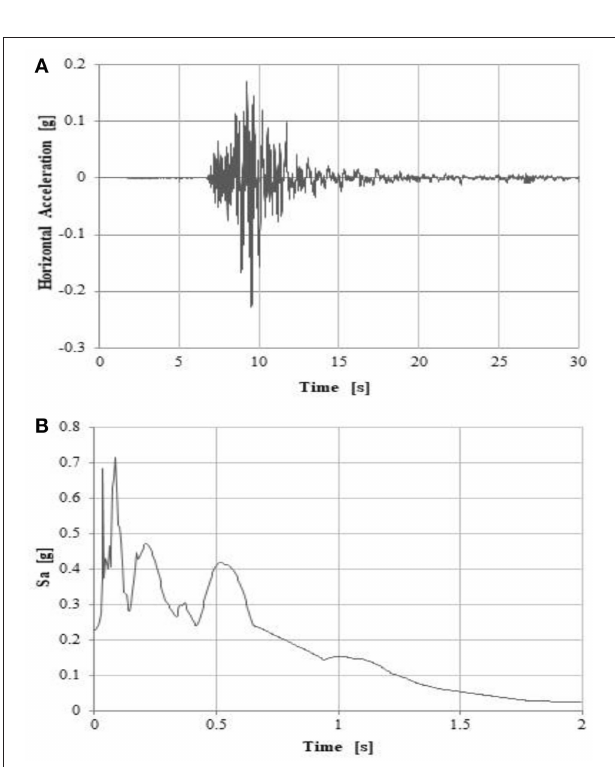
FIGURE 2 | (A) The accelerogram recorded by the station of Mascioni (18th of January 2017). (B) The corresponding 5% damped elastic